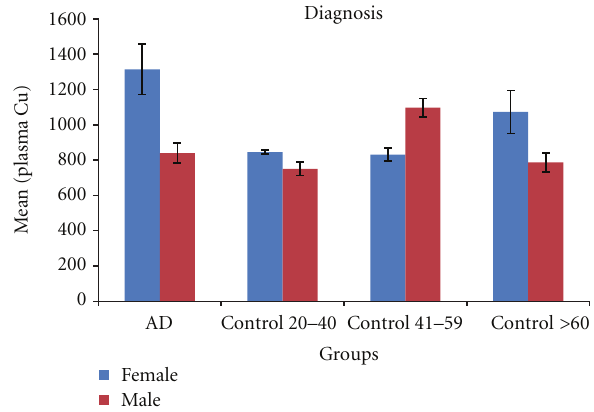
Figure 3: Plasma copper levels (mean ± SEM) in human AD and control subjects. Plasma copper is significantly increased in female AD ( n = 11) compared to male AD ( n = 23) ( P = 0 . 005). There is a trend to increased plasma copper in old female control subjects ( n = 6) compared to old male control subjects ( n = 8) ( P = 0 . 09) and in female middle-aged control subjects ( n = 8) compared to middle- aged male control subjects ( n = 8) ( P = 0 . 13). When all healthy control subjects in each gender are combined, there is a significant di ff erence in plasma copper ( P = 0 . 01, see text).